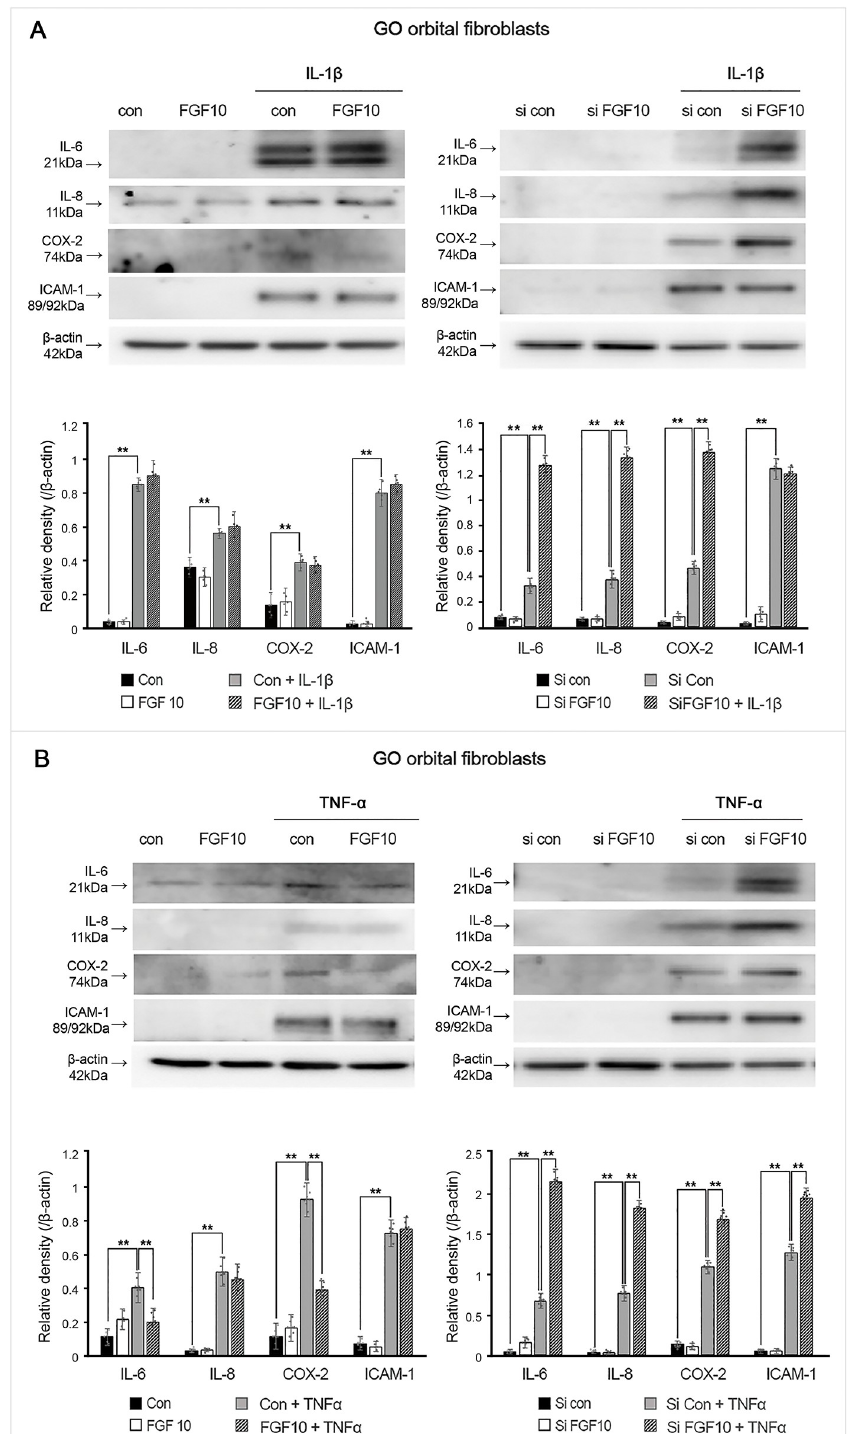
Fig 6. Effect of upregulation of fibroblast growth factor 10 (FGF10) using recombinant human (rh) FGF10 or blockage of FGF10 by small interfering (si) FGF10 transfection on interleukin (IL)-1 β or tumor necrosis factor (TNF)- α induced proiflammatory protein expression. (A) FGF10 did not suppress IL-1 β induced IL-6, IL-8, cyclooxygenase (COX)-2, and intercellular adhesion molecule-1 (ICAM-1) in Graves 0 orbitopathy (GO) orbital fibroblasts (OFs). However, knockdown of FGF10 induced the increase of IL-1 β induced IL-6, IL-8 and COX-2